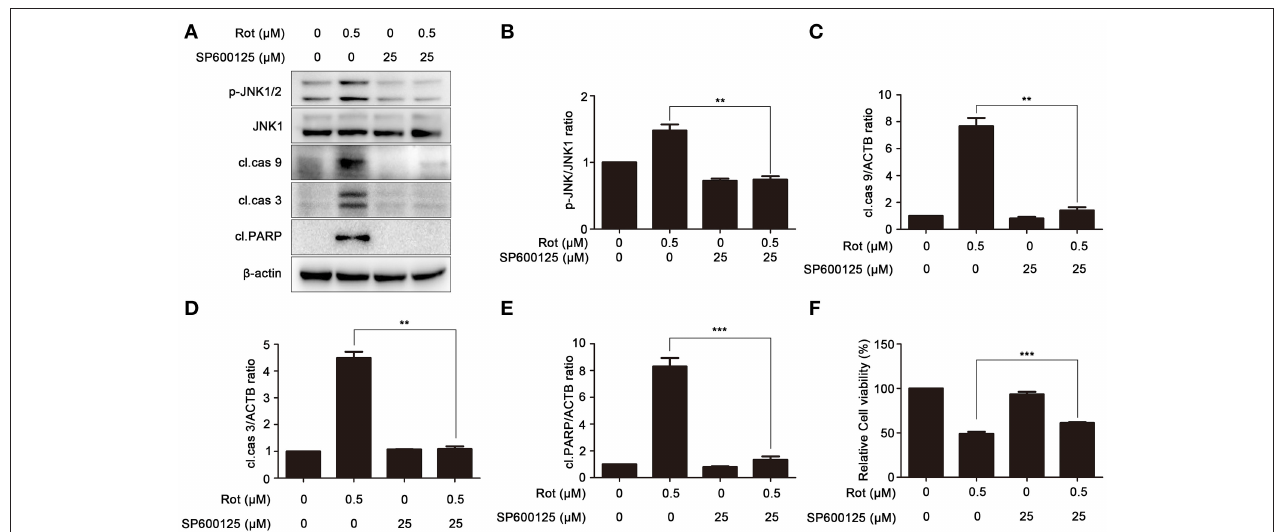
FIGURE 6 | Inhibition of JNK signaling prevents rotenone-induced apoptosis. (A) The SH-SY5Y cells were pretreated with 25 µ M SP600125 (SP) for 1h, and then treated with rotenone for 36h, cleaved PARP, p-JNK and JNK1 were detected by western blot, JNK1 was used as loading control, β -Actin was used as an internal control. Results are representative of at least three experiments. The levels of p-JNK (B) , cleaved caspase-9 (C) , cleaved caspase-3 (D) , cleaved PARP (E) were quantified by densitometry. ** p < 0.01, *** p < 0.001 vs. rotenone-treated group. (F) In the presence or absence of SP, cells were treated with rotenone for 36h, cell viability was assessed by MTT assay. Data are expressed as percent of values in untreated control cultures. *** P < 0.001, compared with rotenone-treated cells.